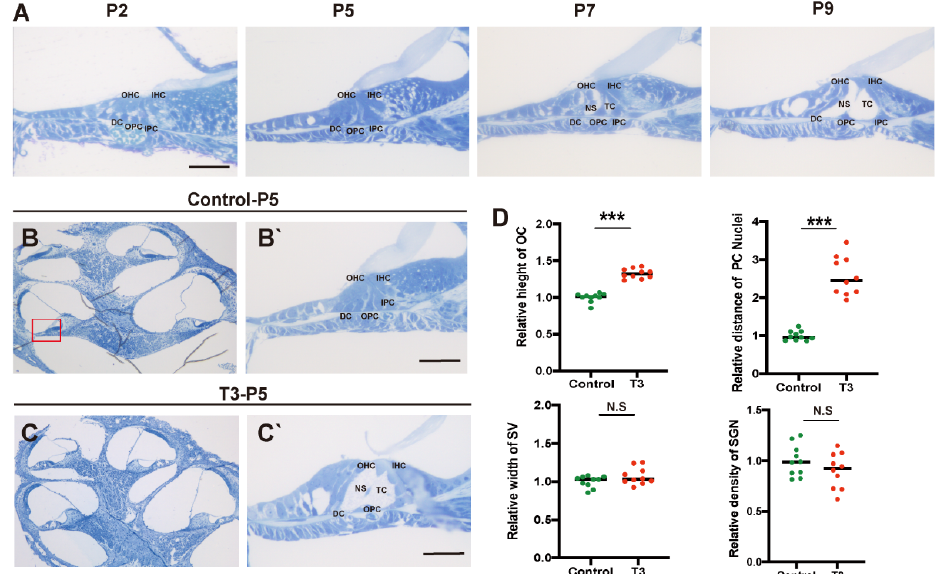
Figure 1. Normal opening of the TC and early opening promoted by T3. ( A ) The OC structure of the normal inner ear at P2, P5, P7 and P9. Plane ( B , C ) shows full views of the cochleae and the middle turn in the organ of Corti; (red frame, ( B’ , C’ )) magnified images for detailed investigation, showing a closed TC from the P5 control group and an opened TC from the P5 T3 group. ( D ) Relative heights of TCs in the control and T3 groups ( n = 3). Relative distance between the nuclei of IPCs and OPCs in the control and T3 groups ( n = 3). Relative SV width of TCs in the control and T3 groups ( n = 3). Relative SGN number in the control and T3 groups ( n = 3). * Significantly different from the control group (*** p < 0.001). N.S means no significance. OC: organ of Corti, TC: tunnel of Corti, NS: Nuel’s space, OPC: outer pillar cell, IPC: inner pillar cell, OHC: outer hair cell, IHC: inner hair cell, DC: Deiters’ cell, SV: stria vascularis, SGN: spiral ganglion neuron. The scales in panel ( A , B’ , C’ ) represent 40 µ